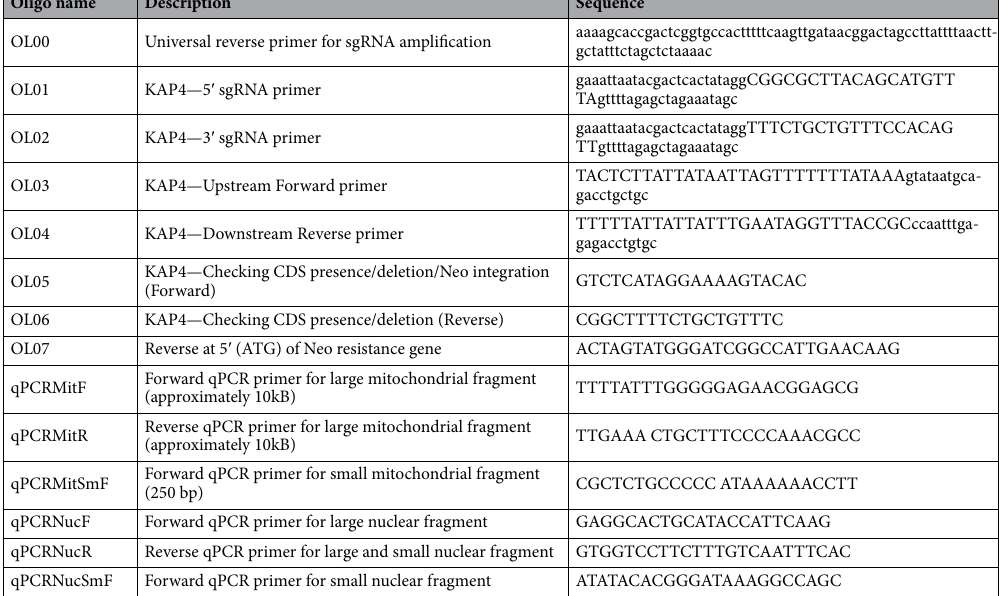
Table 1. List of oligonucleotides for CRISPR-Cas9 in A. deanei , including sgRNA, repair template and diagnostic PCR . Sequences are written in the 5 ′ to 3 ′